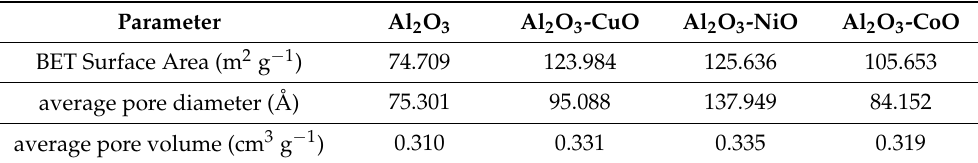
Table 1. The surface characteristics of the prepared Al 2 O 3 , Al 2 O 3 -CuO, Al 2 O 3 -NiO, and Al 2 O 3 -CoO nanomaterials.